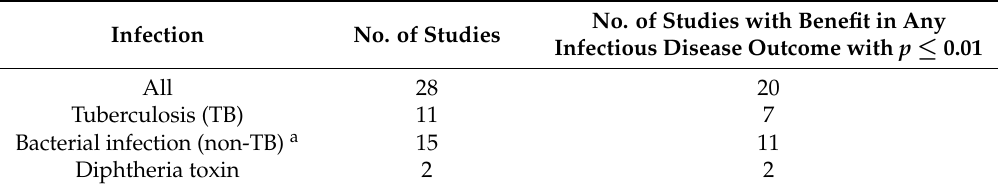
Table 1. Effect of vitamin-C-rich foods on infections in guinea pigs. No. of Studies with Benefit in Any Infection No. of Studies Infectious Disease Outcome with p ≤ 0.01 All 28